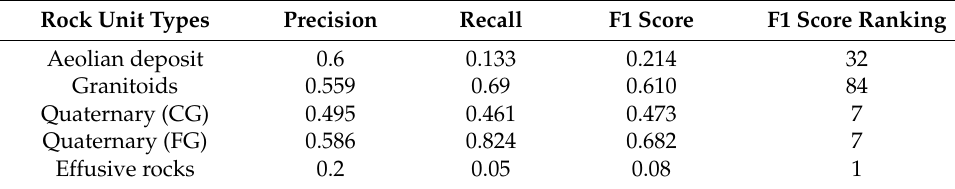
Table 7. Classification accuracy of various rock types corresponding to db13.